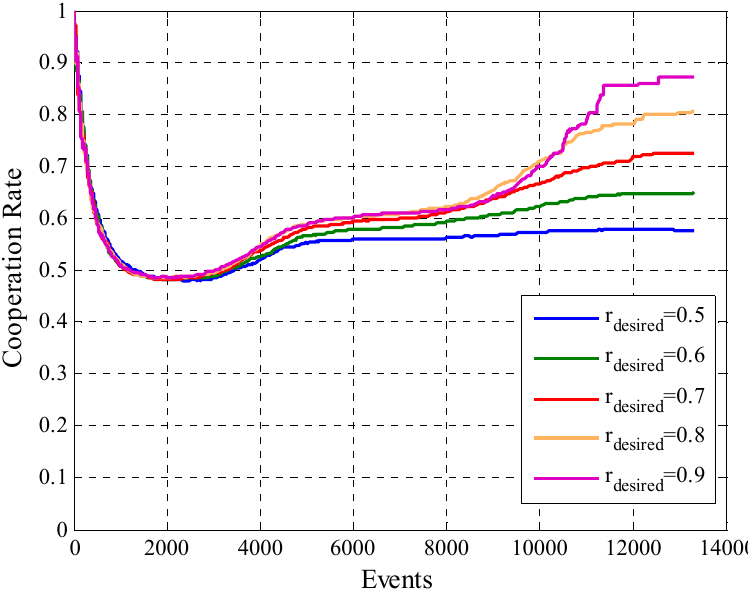
ff erent values of r desired .